Question: What type of chart is this?
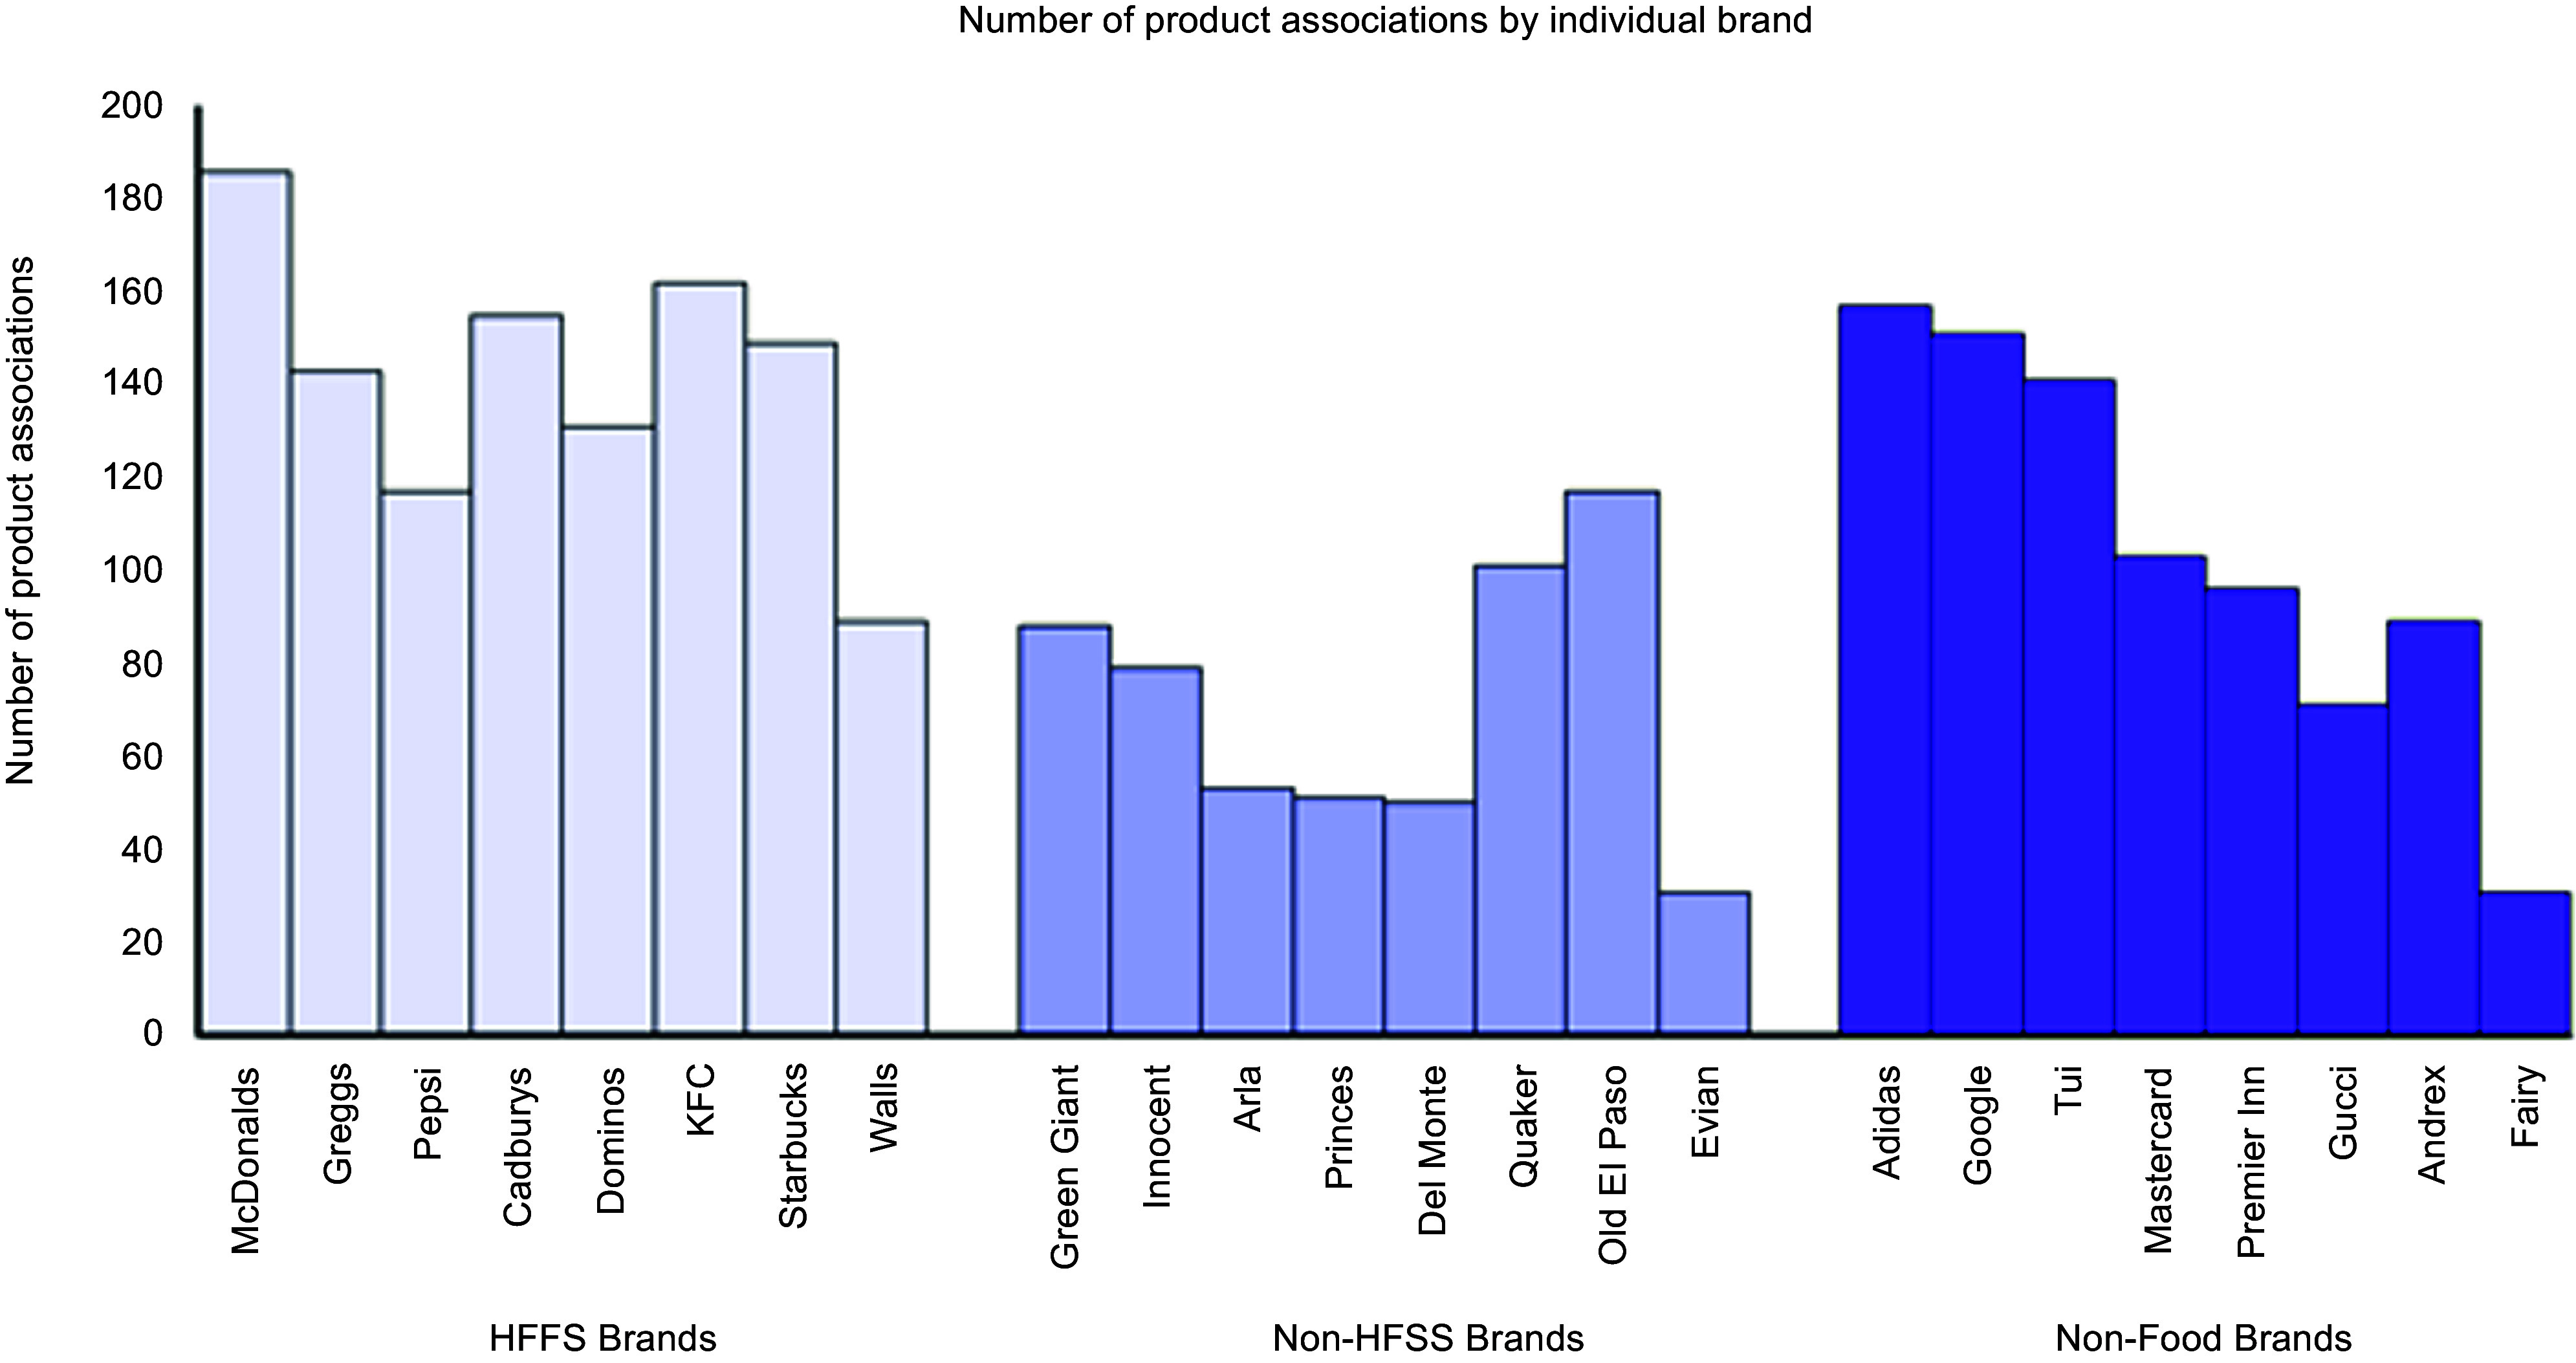
Answer: bar